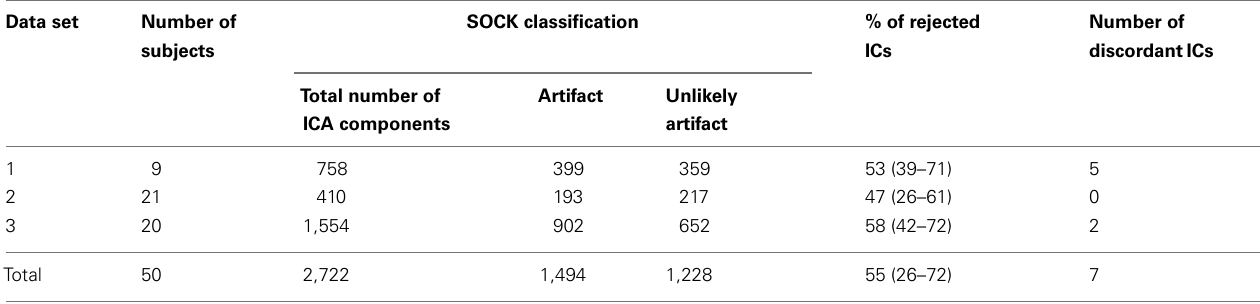
Table 3 |A summary of the SOCK classification for 50